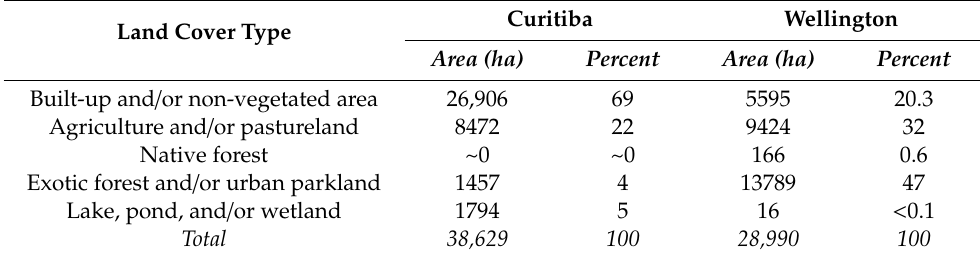
Table 5. The extent of land-cover types in Curitiba and Wellington. Land Cover